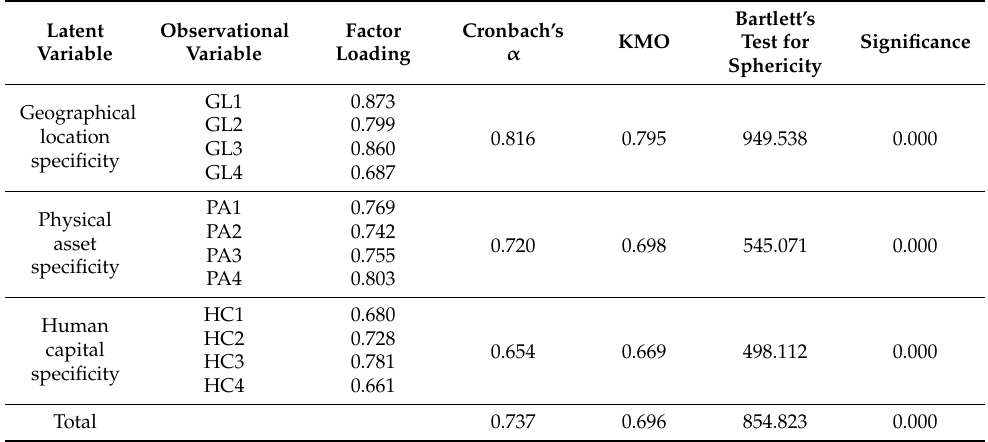
Table 4. Reliability test and validity test results.